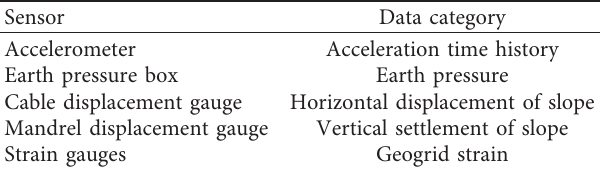
Table 2: Categories of sensor-collected data.